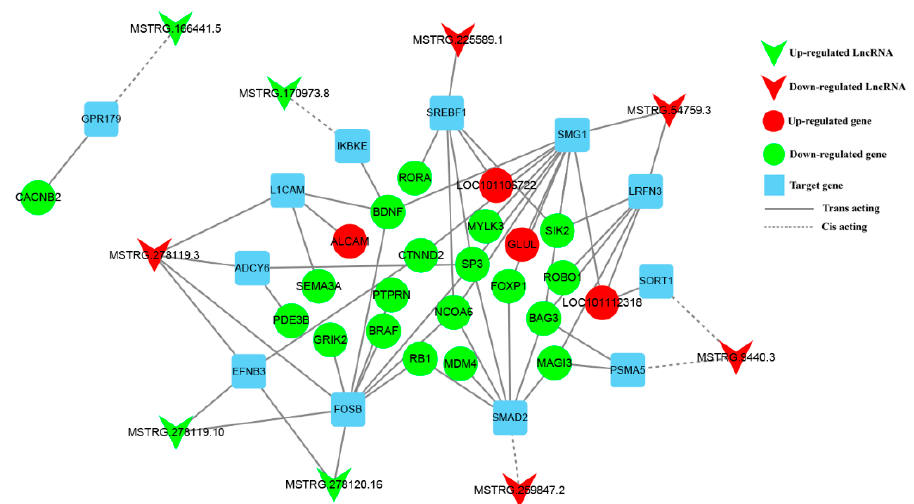
Figure 7. DE lncRNAs, targeted genes and DEGs were composed of the interactive network. The red and green colors represent up and down regulation, the quadrilateral, box and circles represent lncRNAs, targeted genes and DE genes, the straight line and dotted line represent the interaction relationship between trans- and cis-regulation respectively. GPR179 , G protein-coupled receptor 179; CACNB2 , calcium voltage-gated channel auxiliary subunit β 2; SREBF1 , sterol regulatory element binding transcription factor 1; SMG1 , suppressor of morphogenesis in genitalia 1; LRFN3 , leucine rich repeat and fibronectin type III domain containing 3; SORT1 , sortilin 1; PSMA5 , proteasome subunit α 5; SMAD2 , SMAD family member 2; FOSB , FosB proto-oncogene, AP-1 transcription factor subunit; EFNB3 , ephrin B3; ADCY6 , adenylate cyclase 6; L1CAM , L1 cell adhesion molecule; IKBKE , inhibitor of nuclear factor kappa B kinase subunit epsilon; ALCAM , activated leukocyte cell adhesion molecule; GLUL , glutamate-ammonia ligase; RORA , RAR related orphan receptor A; BDNF, brain derived neurotrophic factor; MYLK3 , myosin light chain kinase 3; SIK2 , salt inducible kinase 2; CTNND2 , catenin delta 2; SP3 , Sp3 transcription factor; SEMA3A , semaphorin 3A; PTPRN , protein tyrosine phosphatase, receptor type N; NCOA6 , nuclear receptor coactivator 6; FOXP1 , forkhead box P1; ROBO1 , roundabout guidance receptor 1; BAG3 , BCL2 associated athanogene 3; GRIK2 , glutamate ionotropic receptor kainate type subunit 2; BRAF , B-Raf proto-oncogene, serine/threonine kinase; RB1 , RB transcriptional corepressor 1; MDM4 , MDM4, p53 regulator; MAGI3 , membrane associated guanylate kinase, WW and PDZ domain containing 3.